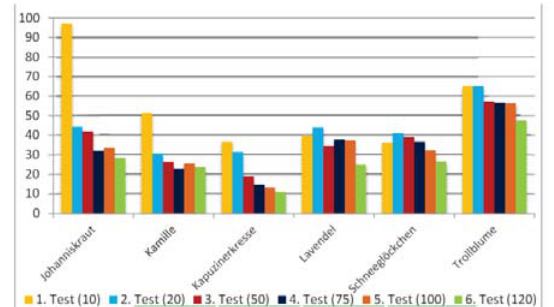
Figure 18: Average wrong classifications in % of each class for different number N of training images (classes 7-12) for original images (Source: Miller, 2014).